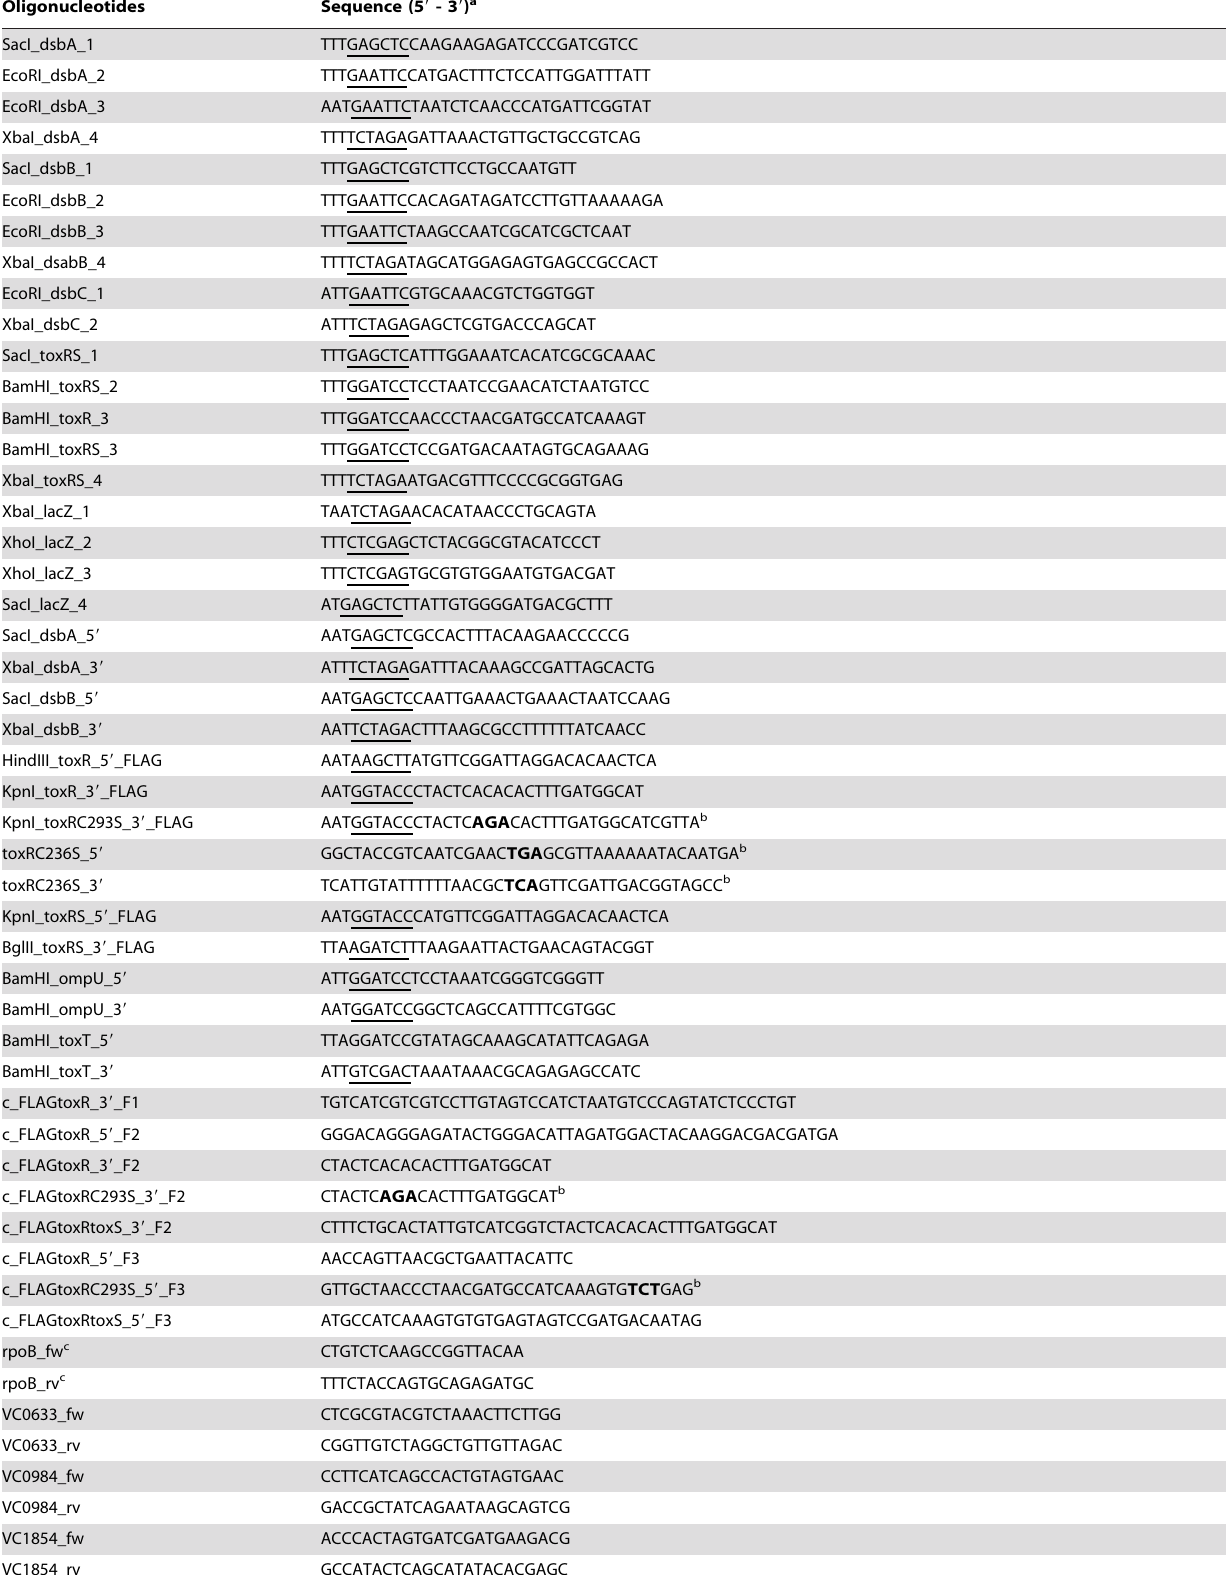
Table 2. Oligonucleotide primers.